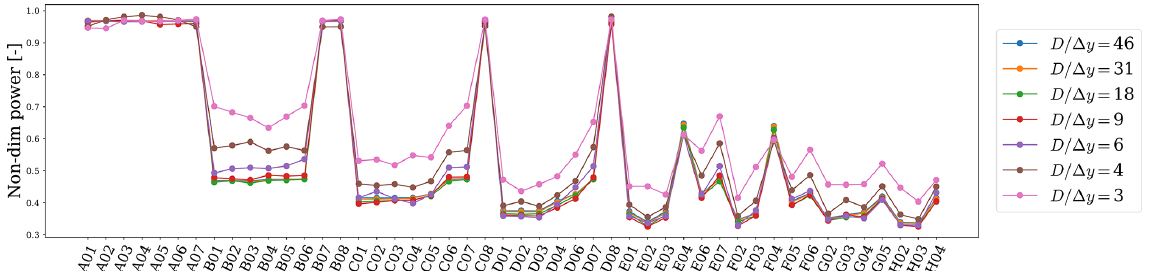
Figure C1. Comparison of turbine power for all turbines using different number of grid points across the turbine diameter for the Lillgrund wind plant for cases at wind direction of 185 ◦